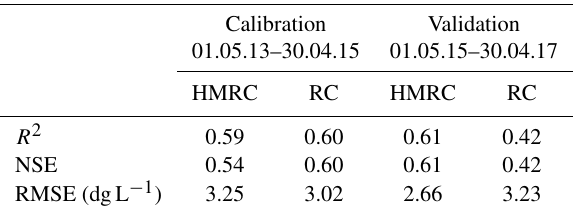
Table 1. Goodness of fit measures for the HMRC and the traditional RC in calibration (left) and validation (right): coefficient of deter- mination ( R 2 ), Nash–Sutcliffe efficiency (NSE), root mean squared error